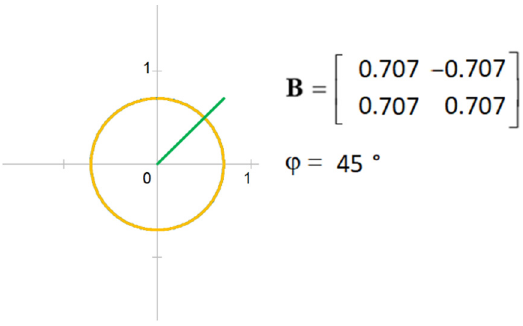
Figure 12. General tensor for rotational matrix with angle 𝜑 = 45° .